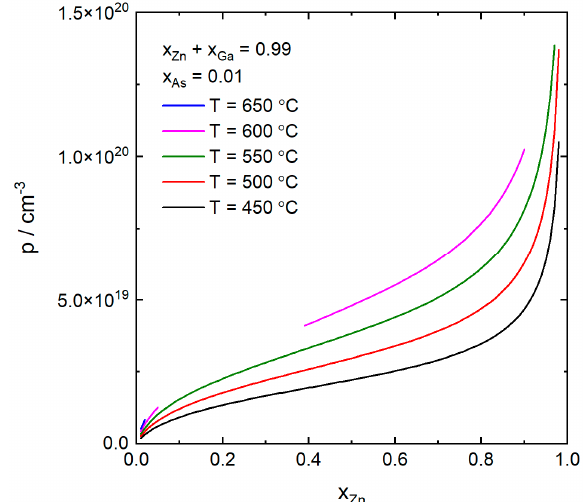
Figure 4. The p-doping concentration as a function of the atomic fraction of Zn in the catalyst particle at the same temperatures as in Figure 2 for self-catalyzed growth, that is x Au = 0. The atomic fraction of As was kept constant at x As = 0.01 and the atomic fraction of Zn was varied at the expense of Ga so that x Zn + x Ga = 0.99.